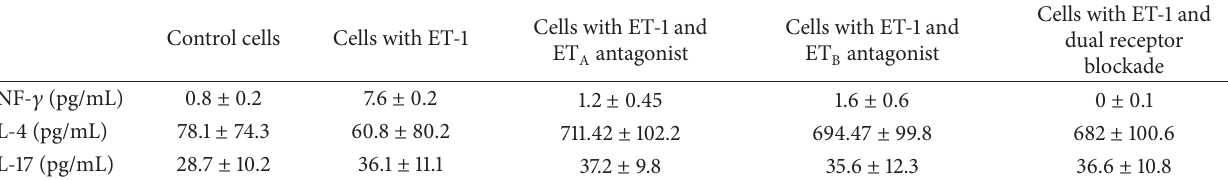
Table 4: Molecules detected in neutrophils supernatants after 1, 3, or 10 hours of incubation with either no stimulus or ET-1, LPS, and ET-1 plus LPS, respectively. No stimulus ET-1 LPS ET-1 + LPS